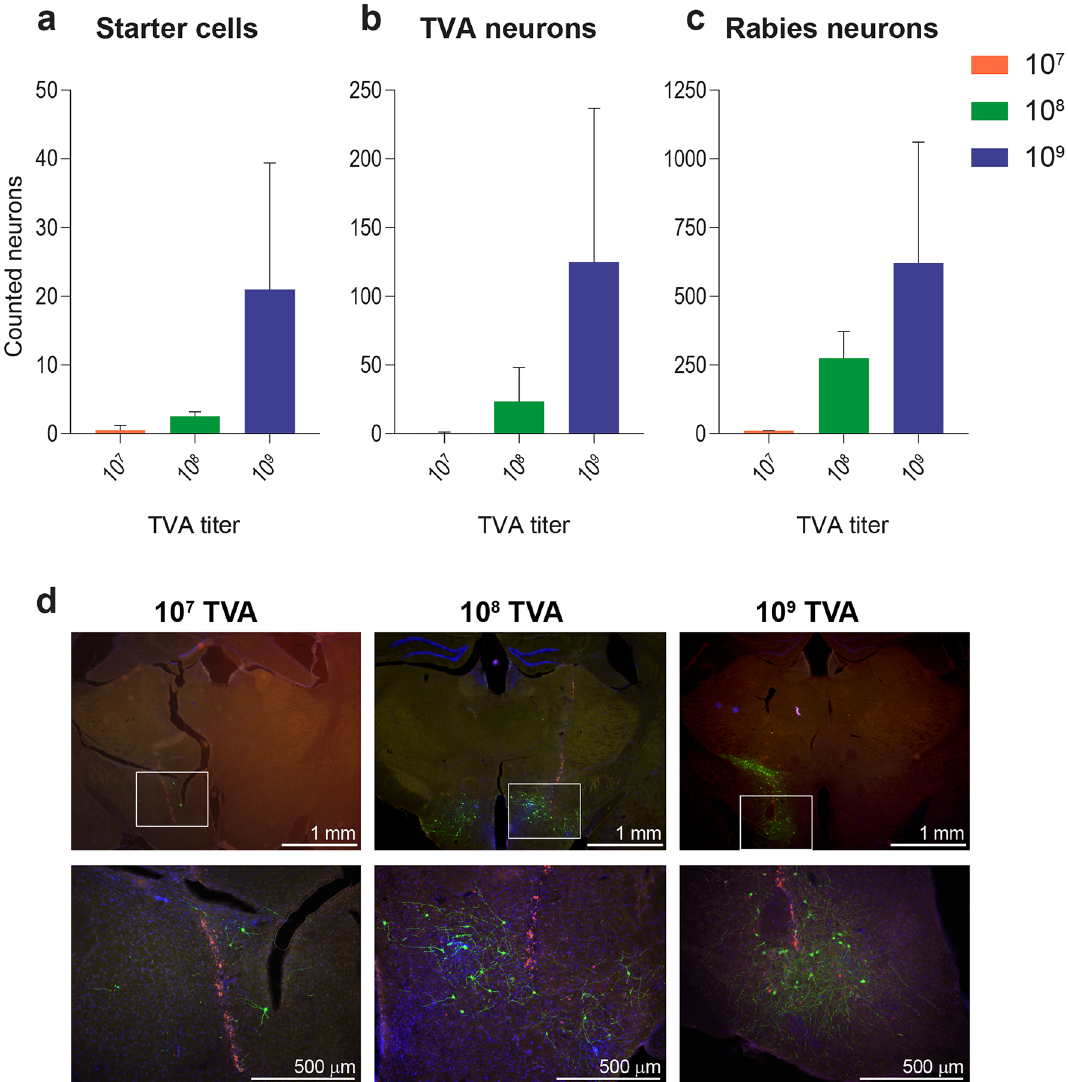
Figure 3. RV d G expression due to TVA leakiness depends on TVA titer. Number of starter cells ( a ), TVA- expressing neurons ( b ), and RV dG -expressing neurons ( c ) were quantified in C57BL6/J Cre-negative control mice that were injected with Cre-dependent TVA and G, followed by SAD-ΔG-eGFP(EnvA) in the LH. Number of starter cells [ F (2,3) = 2.261, p = 0.252], TVA-expressing neurons[ F (2,3) = 2.011, p = 0.279], and RV dG - expressing neurons [ F (2,3) = 2.784, p = 0.207] showed a trend towards an increase with TVA titer, also visible in the representative images with zooms per titer underneath in d. For the 2.5 × images: 3.953 µm/pixel, and for the 10× zooms: 1.018 µm/pixel. Note that injections of 1.0 × 10 7 g.c./µl and 1.0 × 10 8 g.c./µl rAAV5-Flex-TCB were done bilaterally, whereas 1.0 × 10 9 g.c./µl rAAV5-Flex-TCB was done unilaterally. Further, note that the y-axes are different for a , b , and c . Initial version of graphs in a , b , and c was created using GraphPad Prism (version the injections with 1.0 × 10 9 rAAV5-Flex-TCB were performed unilaterally and the injections with 1.0 × 10 7 g.c./ µl and 1.0 × 10 8 g.c./µl rAAV5-Flex-TCB bilaterally. A trend in the same direction was found for TVA-positive cells (Fig. 4b). We found no significant differences between 1.0 × 10 7 g.c./µl and 1.0 × 10 8 g.c./µl rAAV5-Flex- TCB (Figs. 4a,b). No differences in RV d G expression were found between the different titers (Fig. 4c). Example images of the immunohistochemical sections display the same trends and are shown in Fig. 4d. Inputs to LepRb‑expressing LH neurons. Out of four LepRb-Cre mice that were injected with the titer found to be optimally specific and efficient in the qPCR experiment and other previously mentioned experi- ments, being 3.0 × 10 7 g.c./µl rAAV5-Flex-TCB, three were correctly targeted to the LH. We quantified whole- brain RV d G expression to elucidate the different areas that input onto LepRb-expressing LH neurons (Fig. 5a). All areas that contained more than 1% of the total amount of input neurons per single mouse were considered input areas (Fig. 5b). We found that the LH itself, the periventricular hypothalamic nucleus (Pe), the posterior